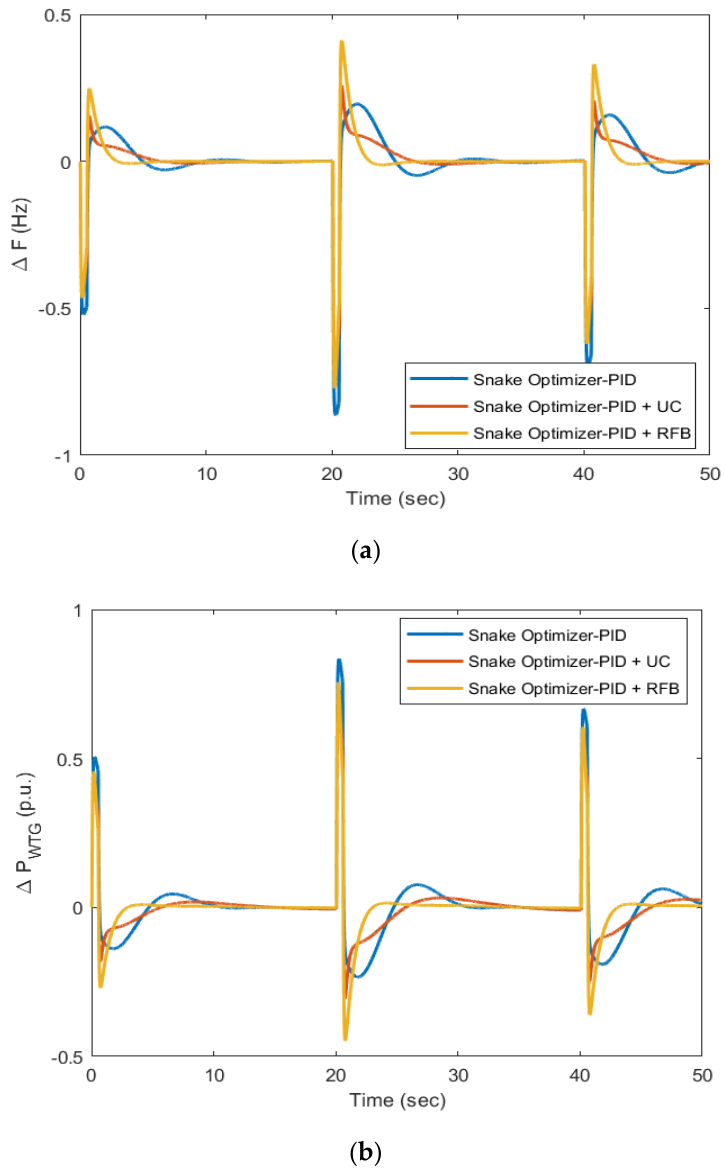
Figure 12. ( a , b ) The comparative output of PID with a UC or RFB for a diesel–wind isolated system for load alterations at different instant of time.